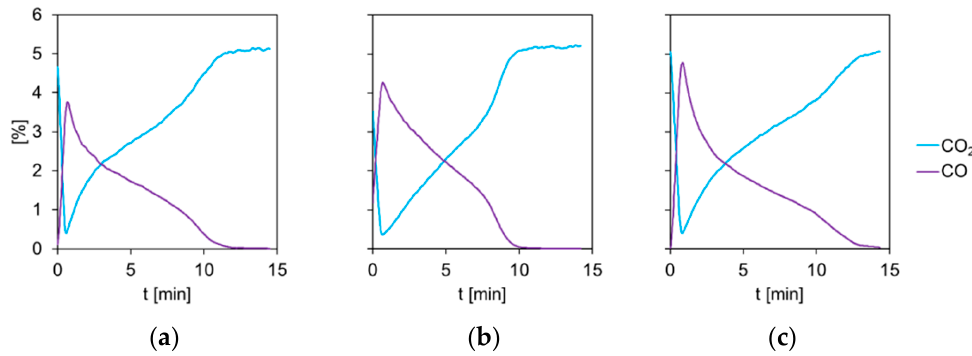
Figure 6. Oxidation steps under fixed-bed conditions at 860 °C ( a ), 920 °C ( b ), 1000 °C ( c ) with 5%. Equations (8)–(11), (13) and (14) were solved for each of the isothermal cycles, and the